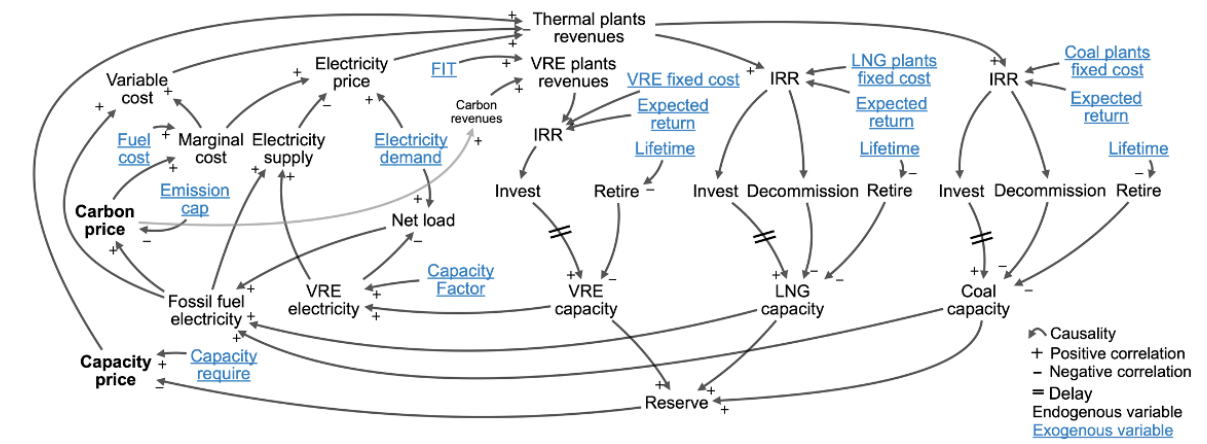
Figure 2. Detailed causal loop diagram of the proposed simulation model.